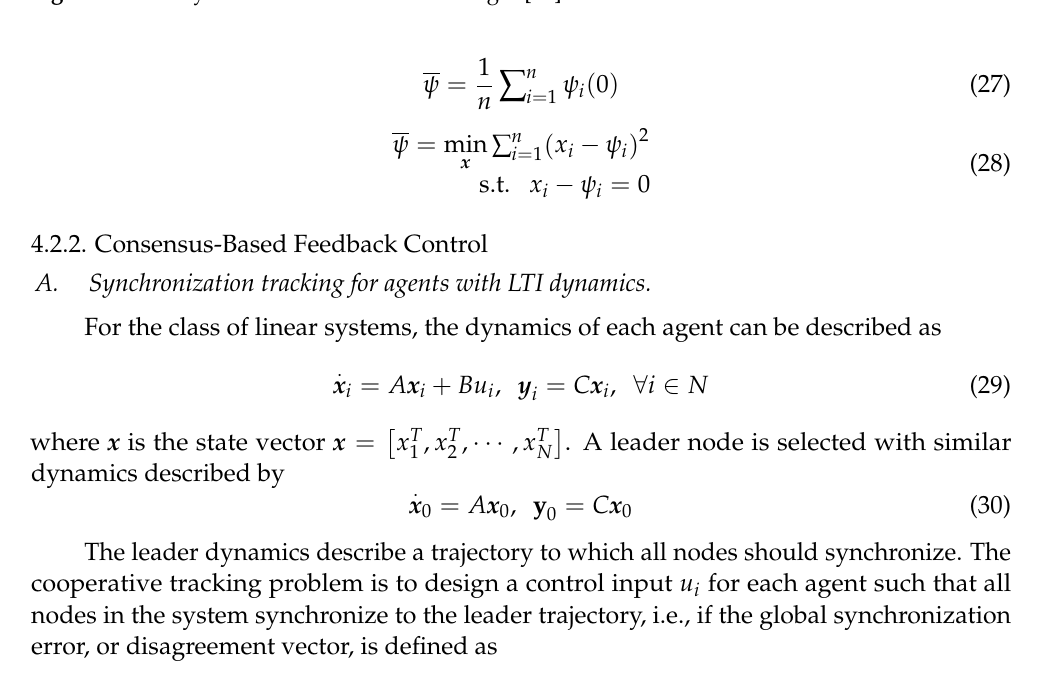
Figure 5. Fast asynchronous distributed averager [51].